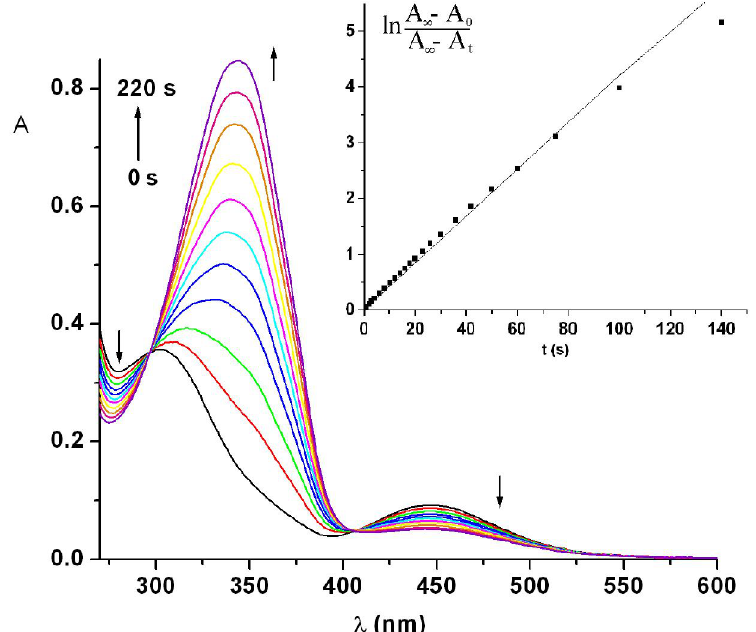
Figure 3. Time evolution of electronic absorption spectra of ABM 2 in DMF under 436 nm light irradiation. Inset shows cis-trans isomerization kinetics. Arrows indicate the directional changes of the